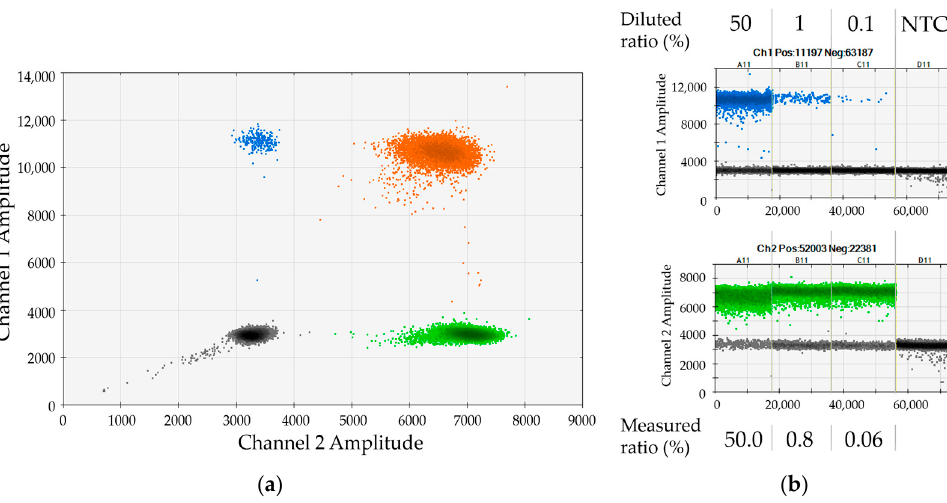
Figure 2. Performance of assay DP70-I in duplex dPCR with SRY ( Sex-determining region of Y gene): ( a ) 2D dot plot displaying results of duplex dPCR combining assays DP70-I (FAM, channel 1) vs. SRY (HEX, channel 2). All four clouds representing double-negative, single-positive and double-positive droplets, respectively, are excellently separated; ( b ) 1D dot plots displaying dPCR-based quantification of serial dilutions of female DP70-I positive mononuclear cells (MNCs) in male DP70-I negative MNCs using the two markers DP70-I and SRY. As indicated, measured ratios of cells are in very good agreement with expected values.